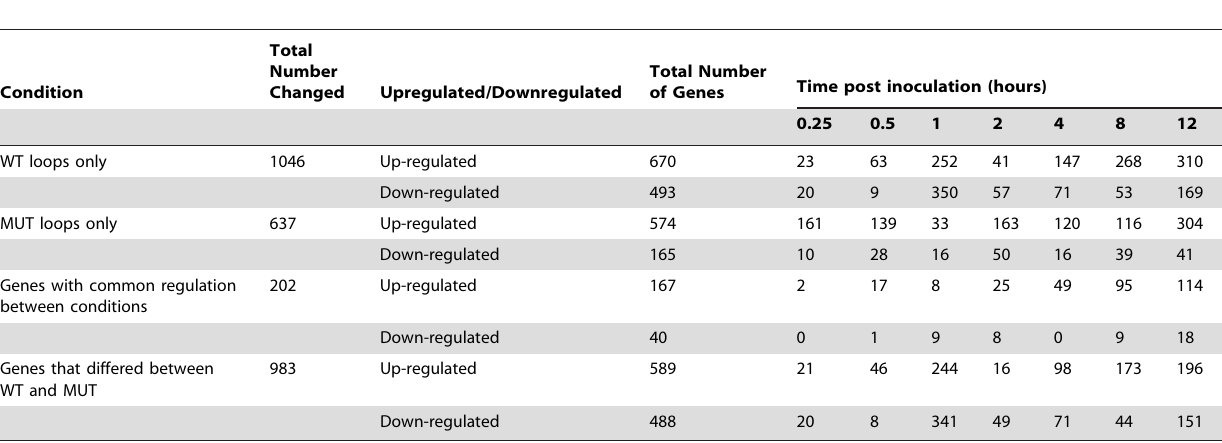
Table 3. Summary of significant genes determined by Bayesian inference z -score using cutoff | z -score| $ 1.96 and |fold-change|